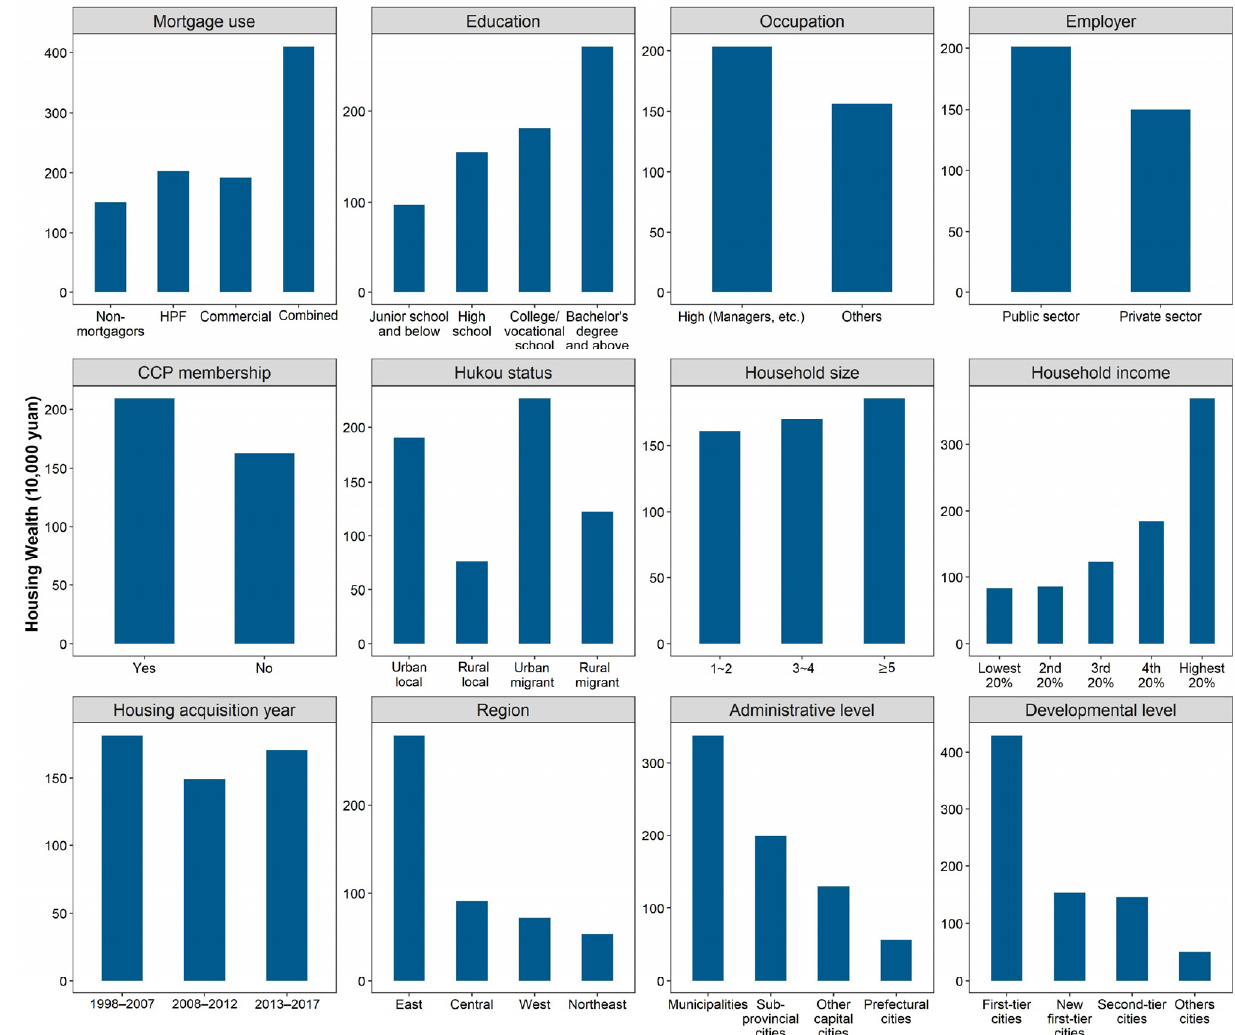
Figure 2. Housing wealth across different groups.